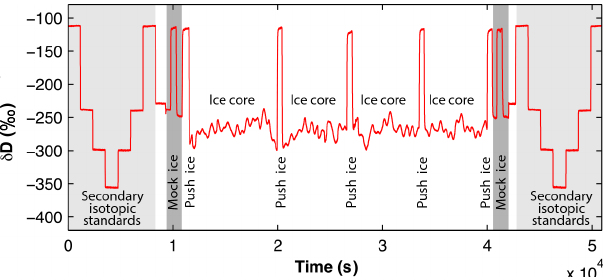
rate of 2.5 cm min − 1 . This melt rate can be increased or de-